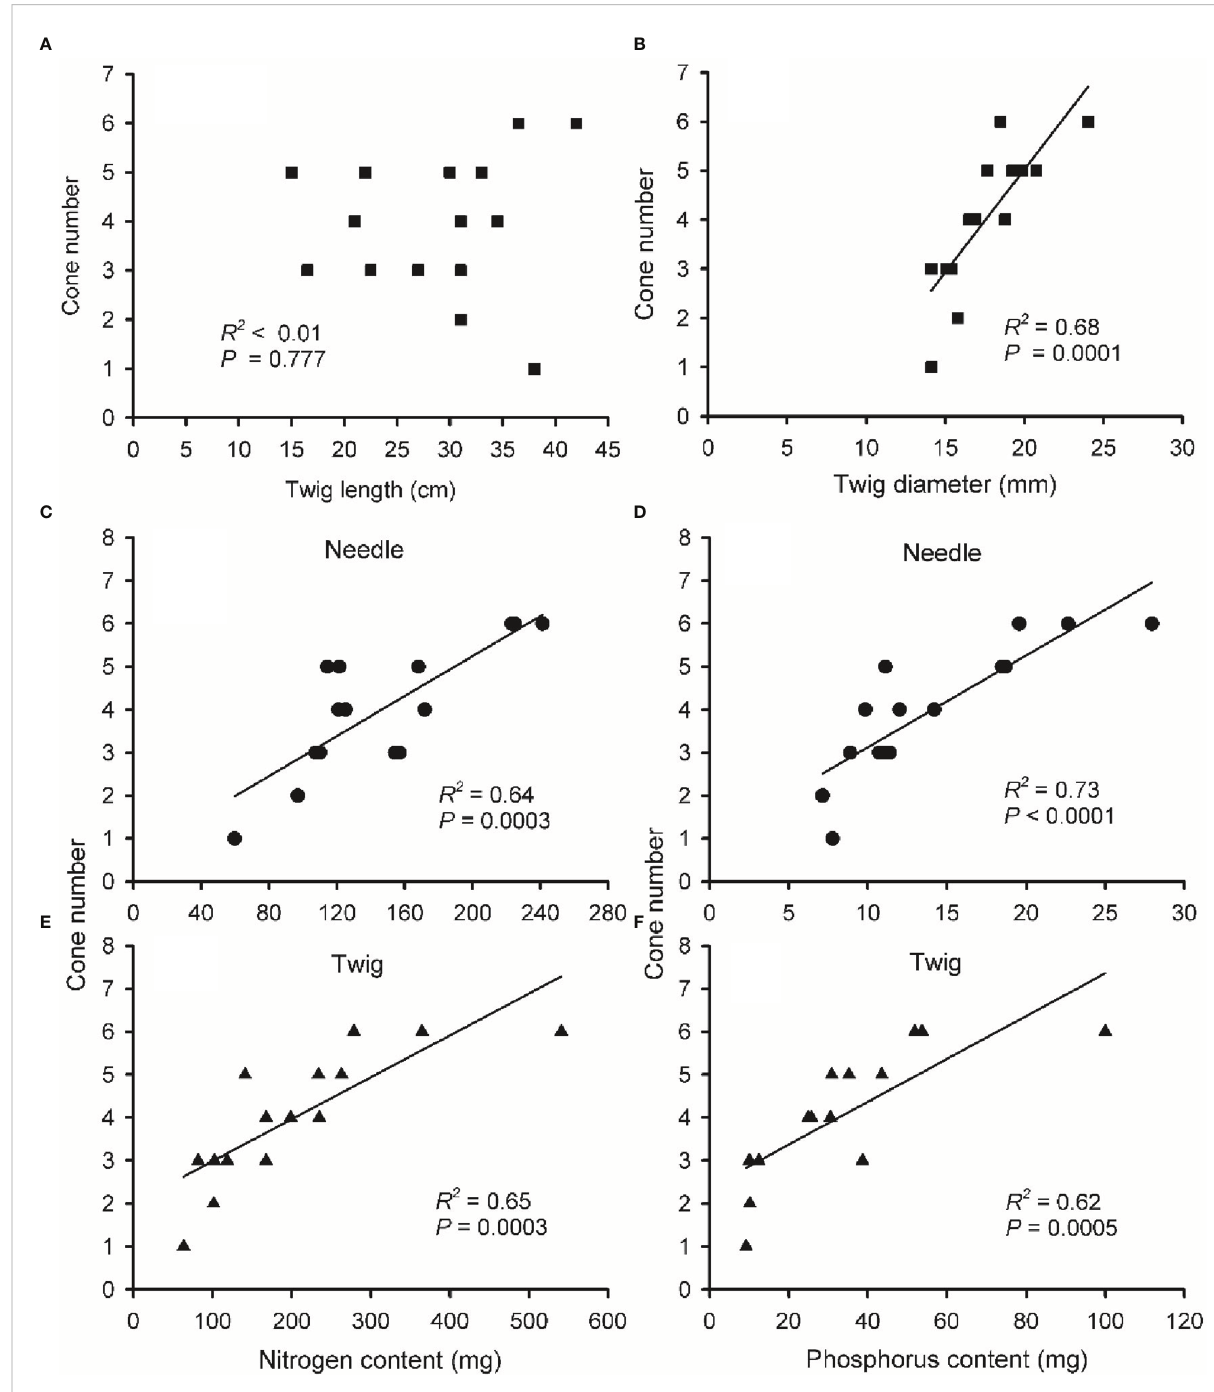
FIGURE 7 The relationship between cone number and twig length (A) , twig diameter (B) , nitrogen ( N; C, E) and phosphorus ( P; D, F) content in needles (C, D) and twigs (E, F) of two-year-old reproductive branches of Pinus koraiensis . Data of cone number, twig size, N and P content were obtained from the last sampling campaign (September; fi ve trees × three twigs). Note that some panels show less than 15 points due to overlaying data. Note the different scales for x-axes among